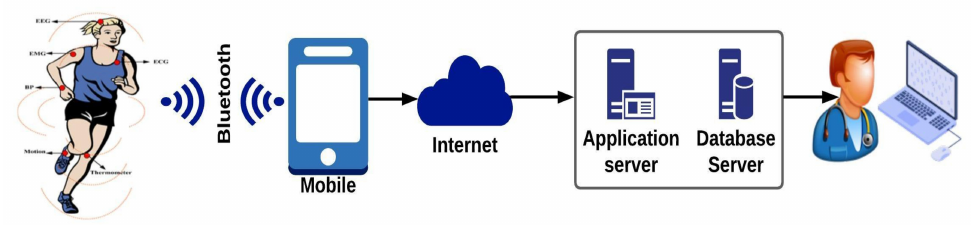
Figure 1. General architecture of WBAN application